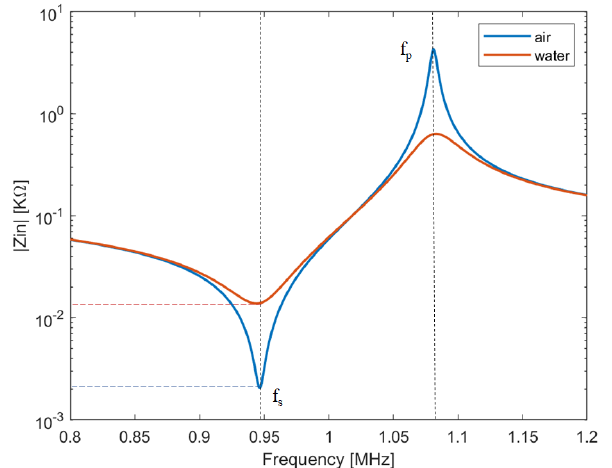
Figure 2. Simulation of the electrical impedance of a piezoceramic element when loaded with air or water to illustrate the impediography technique. The lower the acoustical impedance of the load, the lower the value of the impedance at the series resonance frequency f s